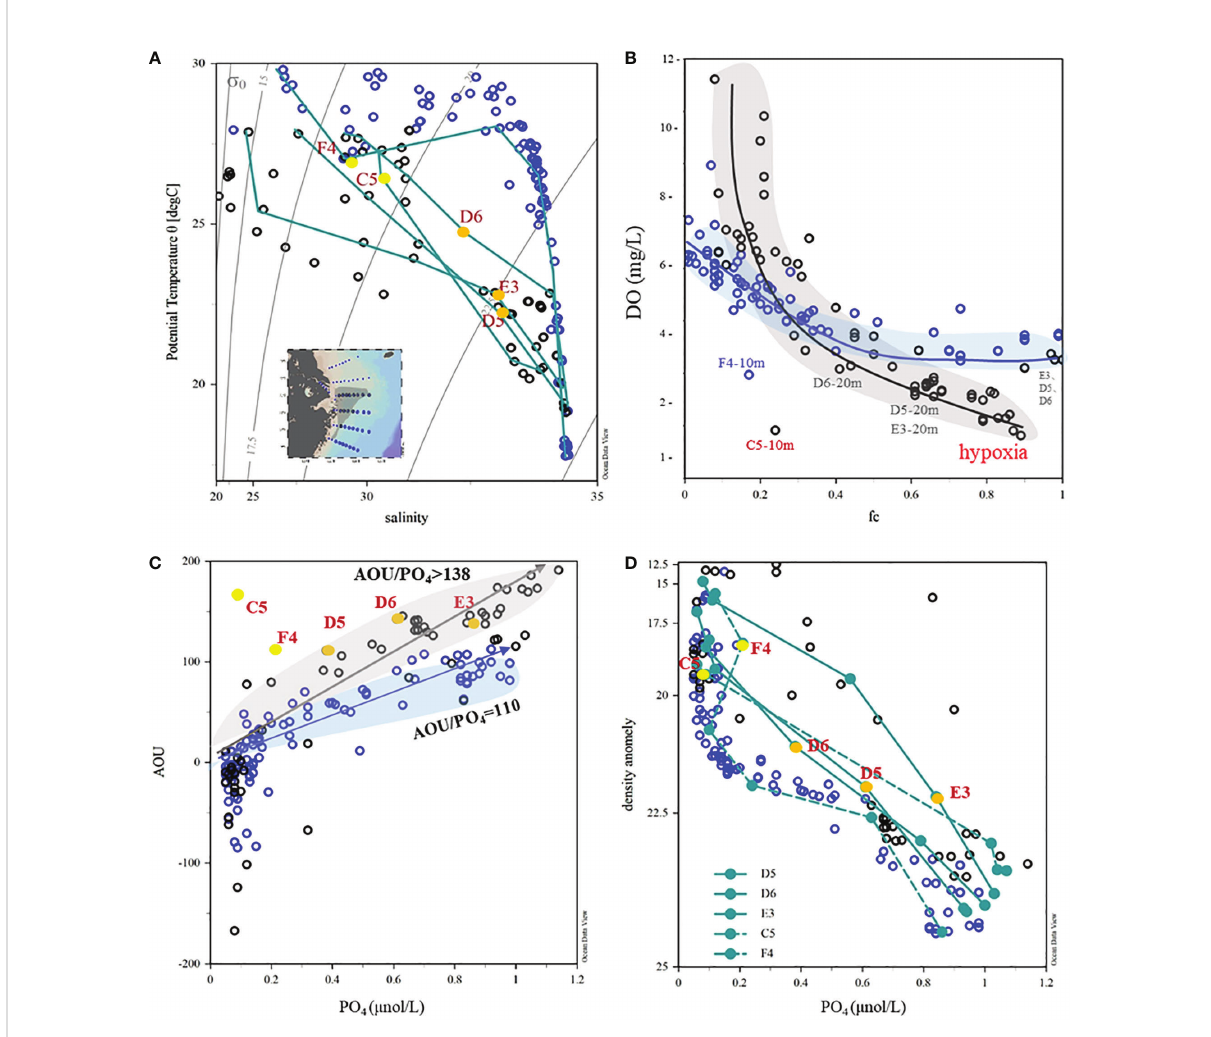
FIGURE 9 Scatter plot of physical and chemical parameters for hypoxia stations and the southern ECS stations. (A) T-S plot; (B) DO, and f c ; (C) AOU and P O 3 − 4 ; (D) density anomaly and AOU and PO 3 − 4